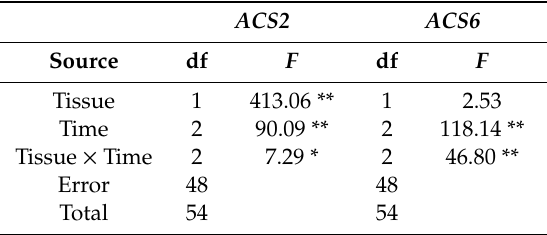
Table 1. Analysis of variance for gene expression of ACS2 and ACS6 in the examined tissues (above ground plant tissues and roots) in the three examined time points (3, 7, and 14 days post-inoculation (dpi)). The analysis was based on the relative gene expression results (2 − ∆ Ct ) of 3 technical repeats of three biological repeats. ACS2 ACS6 Source df F df F Tissue 1 413.06 ** 1 2.53